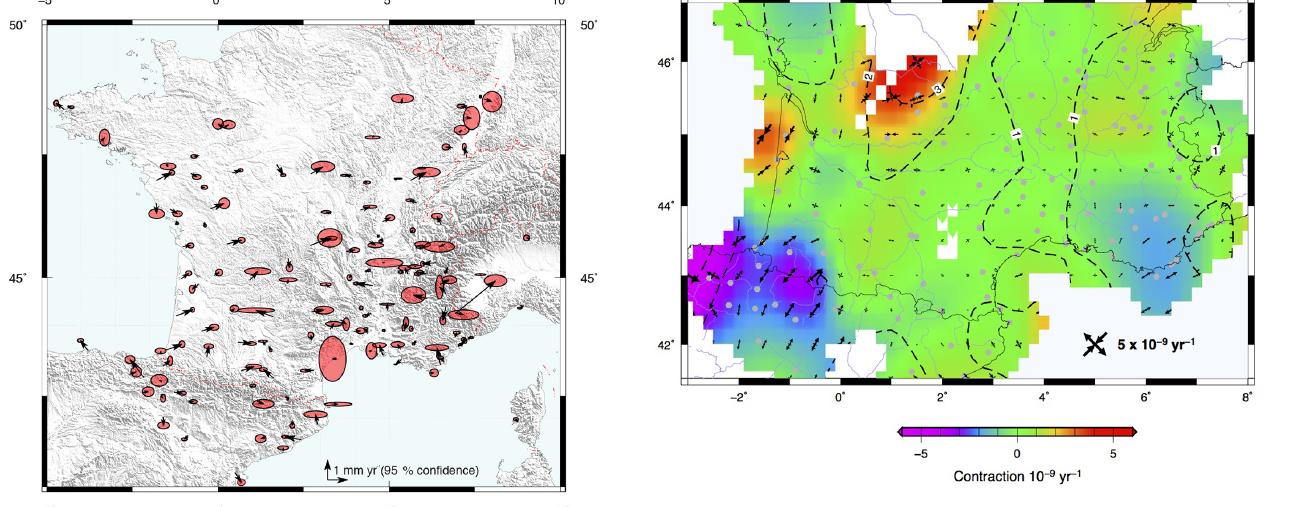
Figure 8. Smoothed horizontal strain rate field for the Western Alps and Pyrenees region. Dashed lines are strain rate standard error. Light grey curves show the drainage pattern and dark grey curves the seashores and country borders.